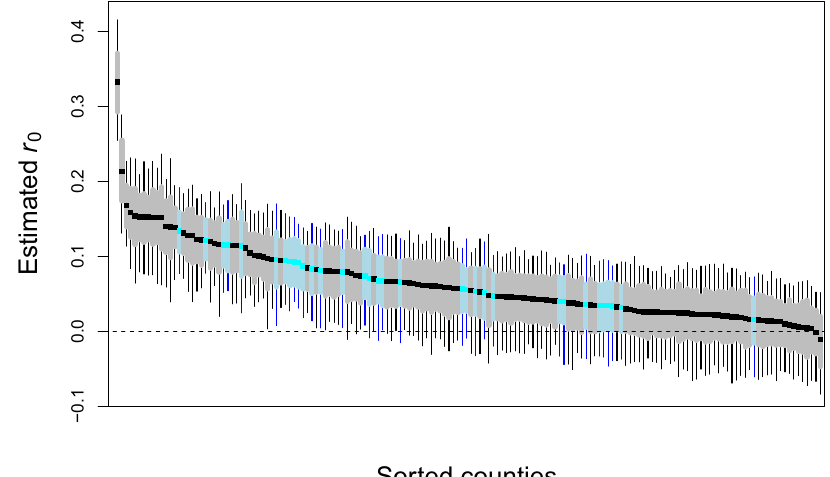
Fig. 1 Estimates of initial spread rate, r 0 . The fi gure shows r 0 point estimates (in black), sorted by magnitude, for 124 counties (gray) and 36 county- aggregates (blue), with 66% (bars) and 95% (whiskers) bootstrapped con fi dence intervals.